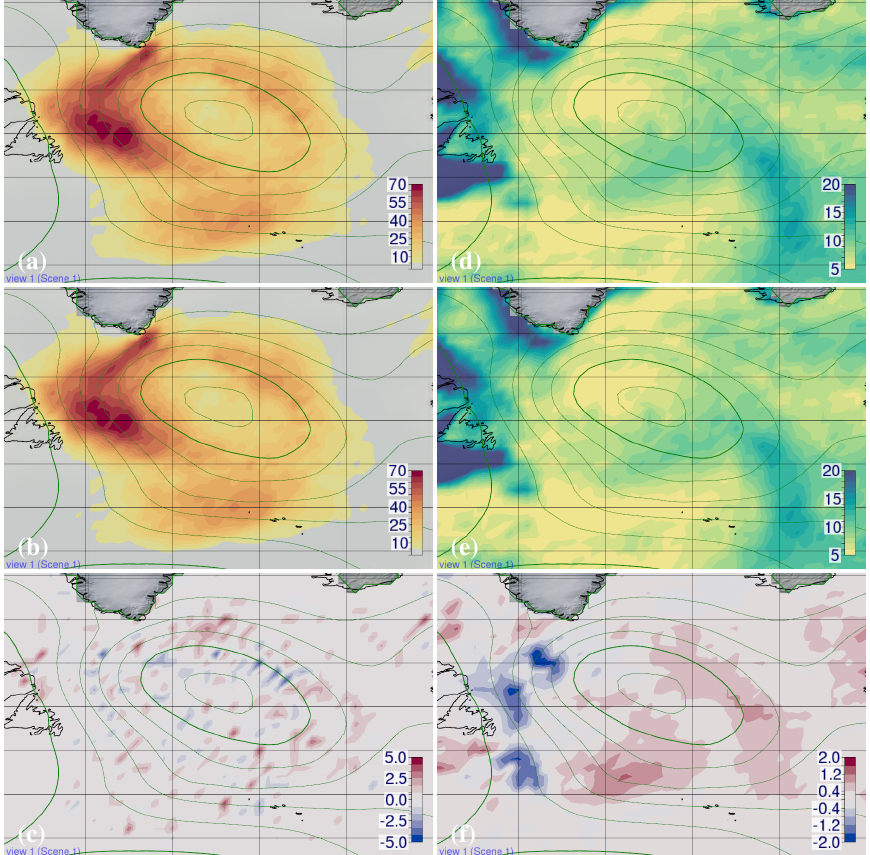
Figure 14. Visual differences between statistical quantities computed from a vertically regridded ensemble to those computed from the original ensemble. Horizontal section at 950hPa (approx. model levels 51–55 in Figs. 15 and 16) of (a–c) p( | v | > 20ms − 1 ) (%) and (d– f) σ( RH ) . Same forecast as in Fig. 13. Shown is (a) the probability and (d) SD computed from the original model grid, ( b and e ) computed from members regridded to the grid defined by the mean p sfc , and ( c and f ) the difference between both